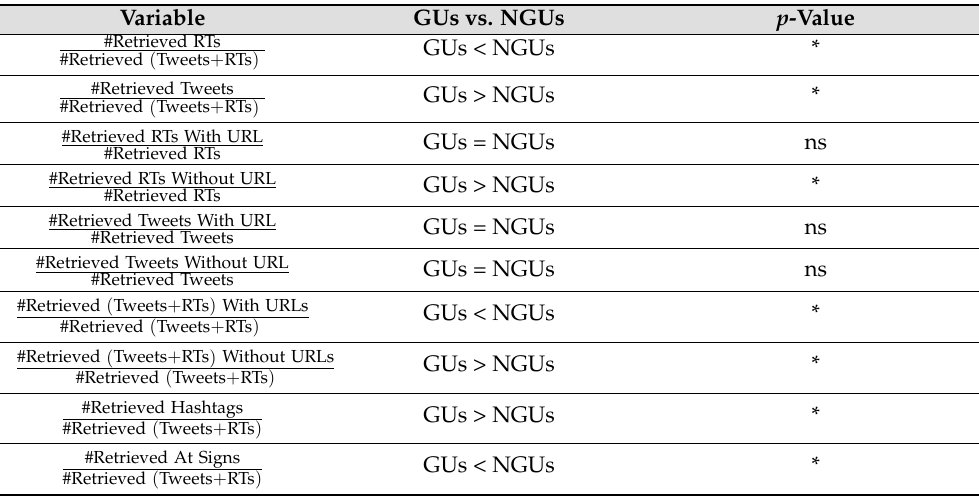
Table 4. GUs vs. NGUs based on the structure of tweets.